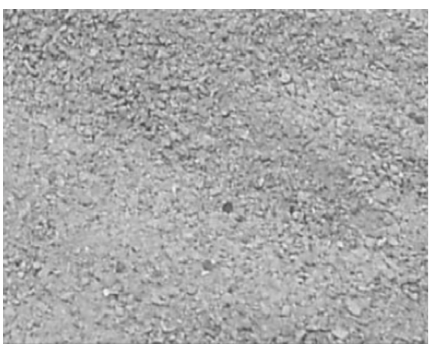
Figure 2: Recycled fine